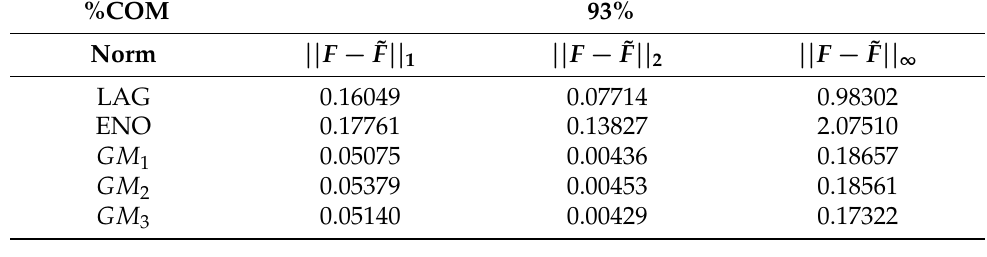
Table 1. Obtained quality after the compression (93%) and decompression process using 2 scales of